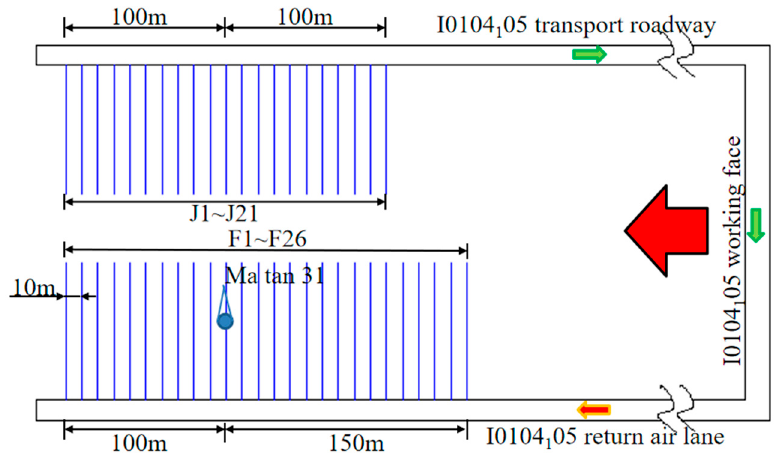
Figure 6. H 2 S concentration test drilling layout of Ma tan 31 oil well.